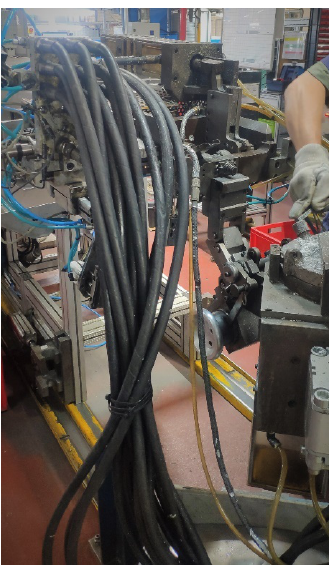
Figure 9. Intervention process impact on premature coup– ling and tunning system wear.